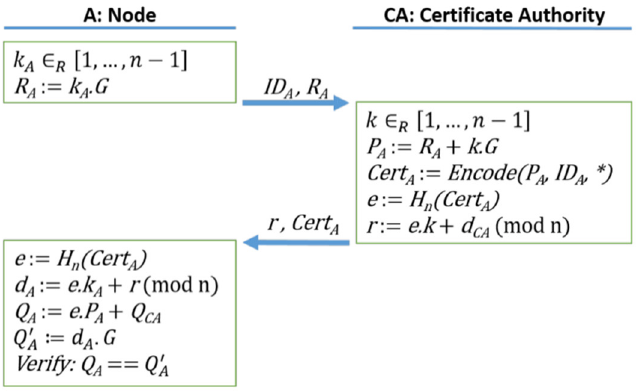
Figure 1. Generation of implicit certificates for ECQV [22].